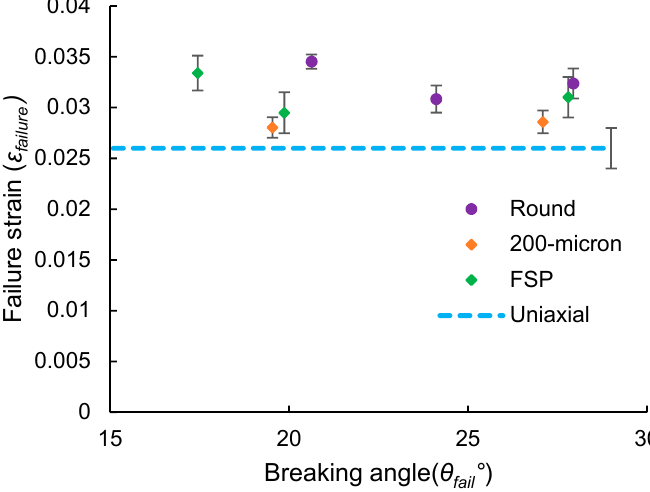
Figure 12. Variation of axial strain vs. breaking angle for the fragment simulating projectile (FSP) geometry.